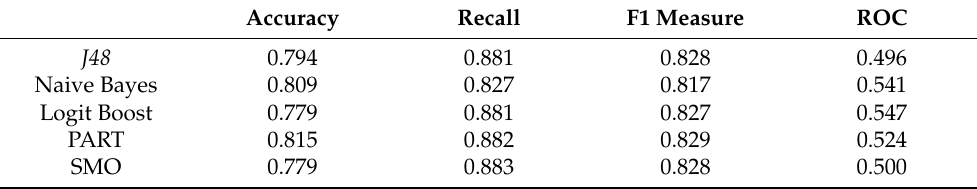
Table 4. Performance indicators—classification using all 27 parameters. Accuracy